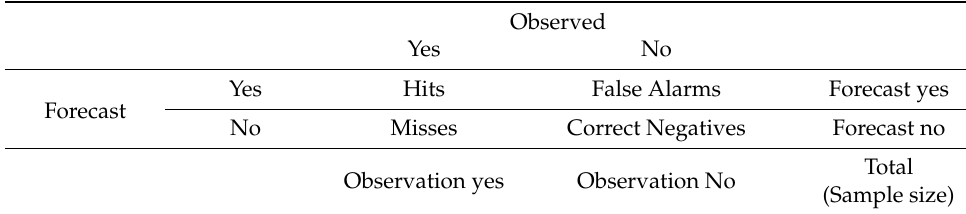
Table 1. Contingency